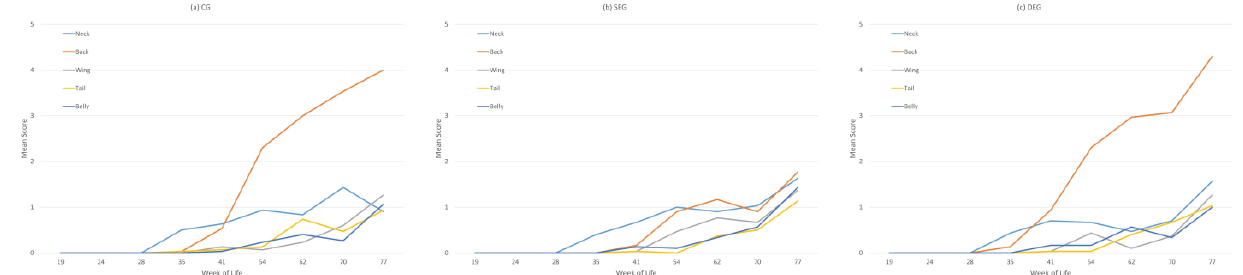
Figure 4. Mean plumage score of 30 hens/group/week of life on a scale of 0 (intact plumage) to 5 (<75% of feathers missing) in five assessed body regions (neck, back, wing, tail, and belly) in the three groups: ( a ) CG = control group, ( b ) SEG = single enrichment group, and ( c ) DEG = double enrichment group during the husbandry period (weeks of life 19 – 77).